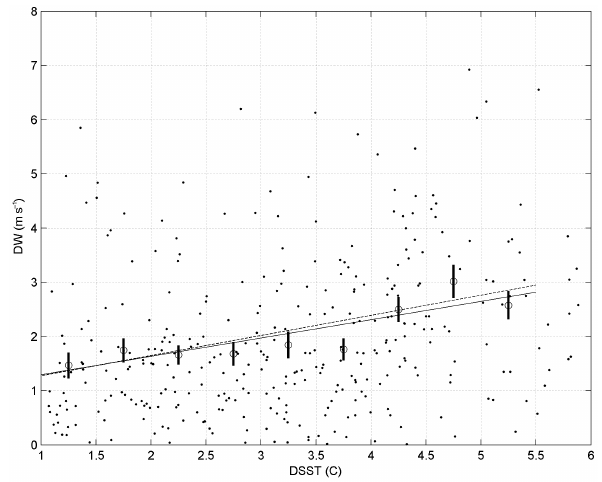
Figure 10. Scatter plot of SST perturbation (DSST) vs. absolute value of wind speed decrease (DW) in ms − 1 downstream of the eddy relative to wind conditions over the core of the eddy for cases when the wind increased above eddies and decreased downstream and for SST perturbation from the surrounding ocean >1 ◦ C. Solid line is a linear fit. The circle represent the means within each 1 ◦ C bin and the error bars represent ± 1 standard deviation of the wind differences within each bin divided by the square root of the number of sample within each bin. The dashed line is a linear fit of the means within the